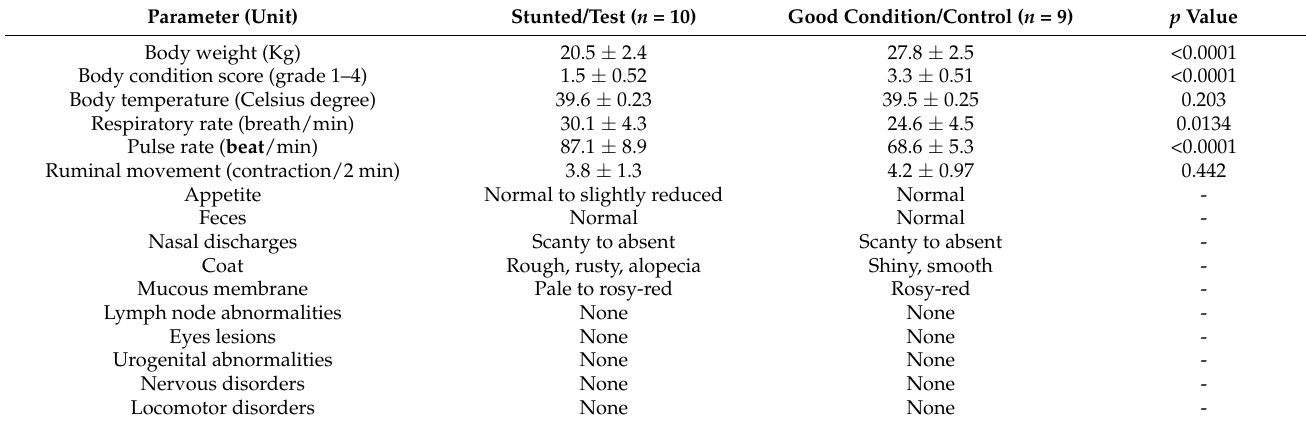
Table 2. Clinical findings among Barki sheep of good and poor condition.